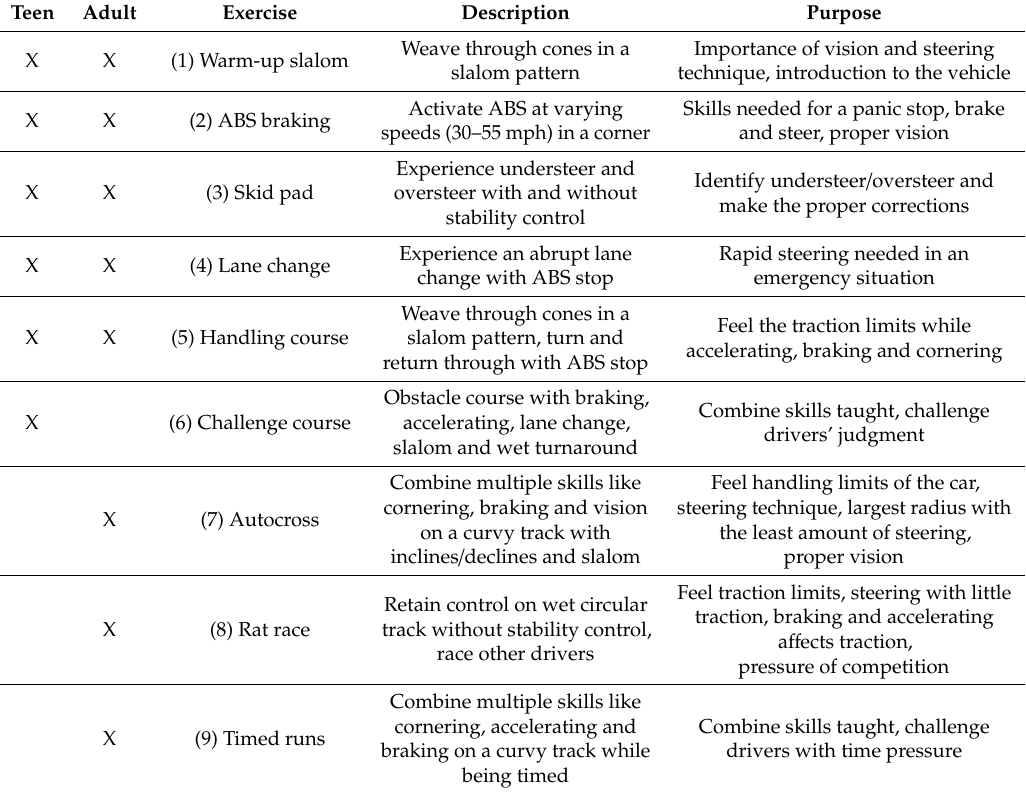
Table 1. Teenage and adult car control class (CCC) exercises, exercise description and exercise purpose. ABS: antilock braking system. The exercise numbers correspond to Figure 1’s track